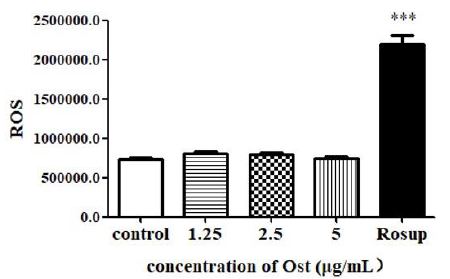
Figure 9. The production of reactive oxygen species (ROS) in granulosa cells post 24 h of treatment with Ost with Rousp was set as a positive control for ROS test. Data were expressed as Mean ± SEM. *** p < 0.001.